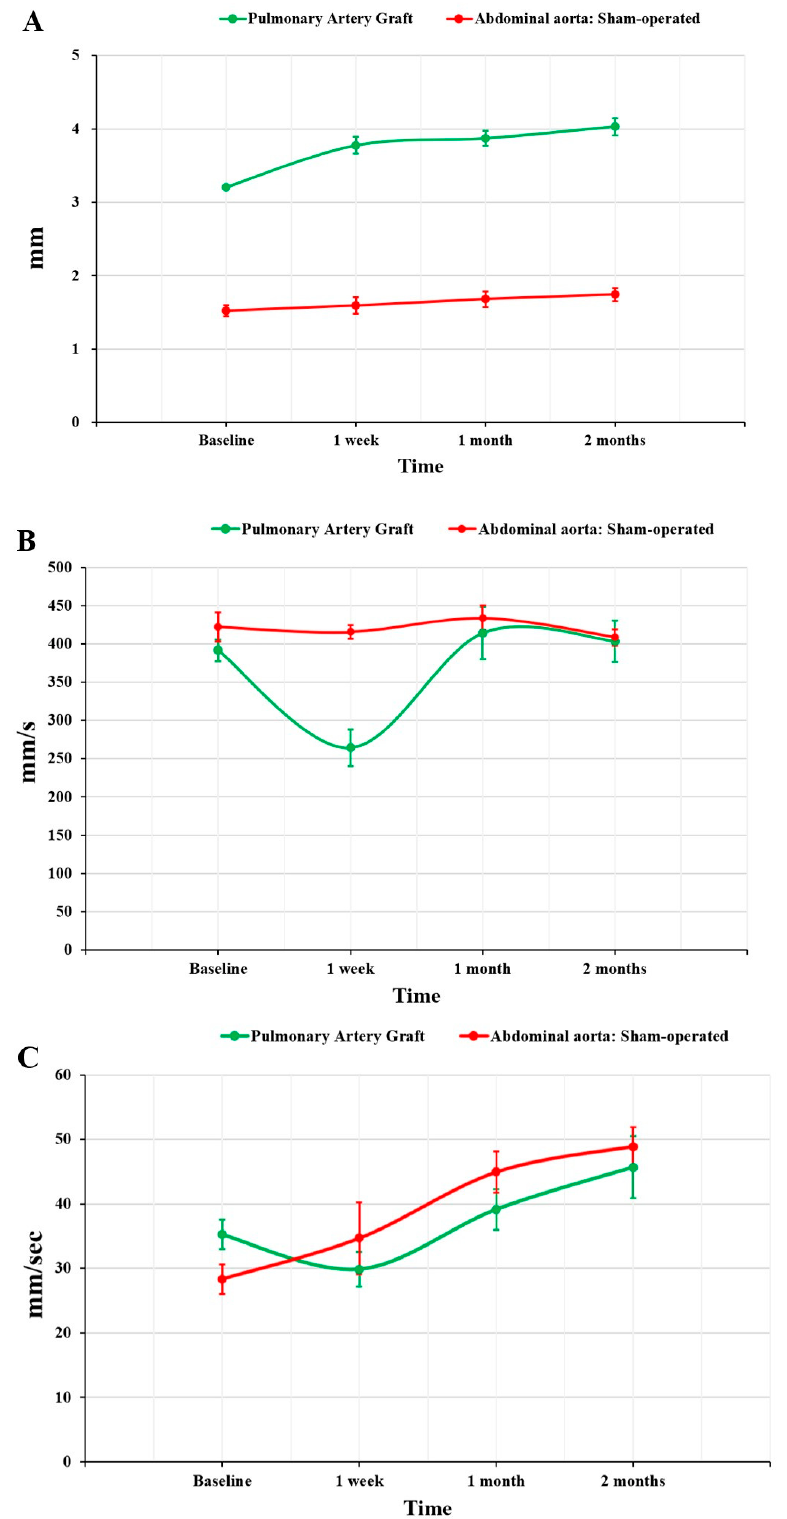
Figure 2. Graphs showing the comparison of the ultrasound parameters between the two groups over the study period. ( A ) Diameter; ( B ) peak systolic velocity; and ( C ) end-diastolic velocity.